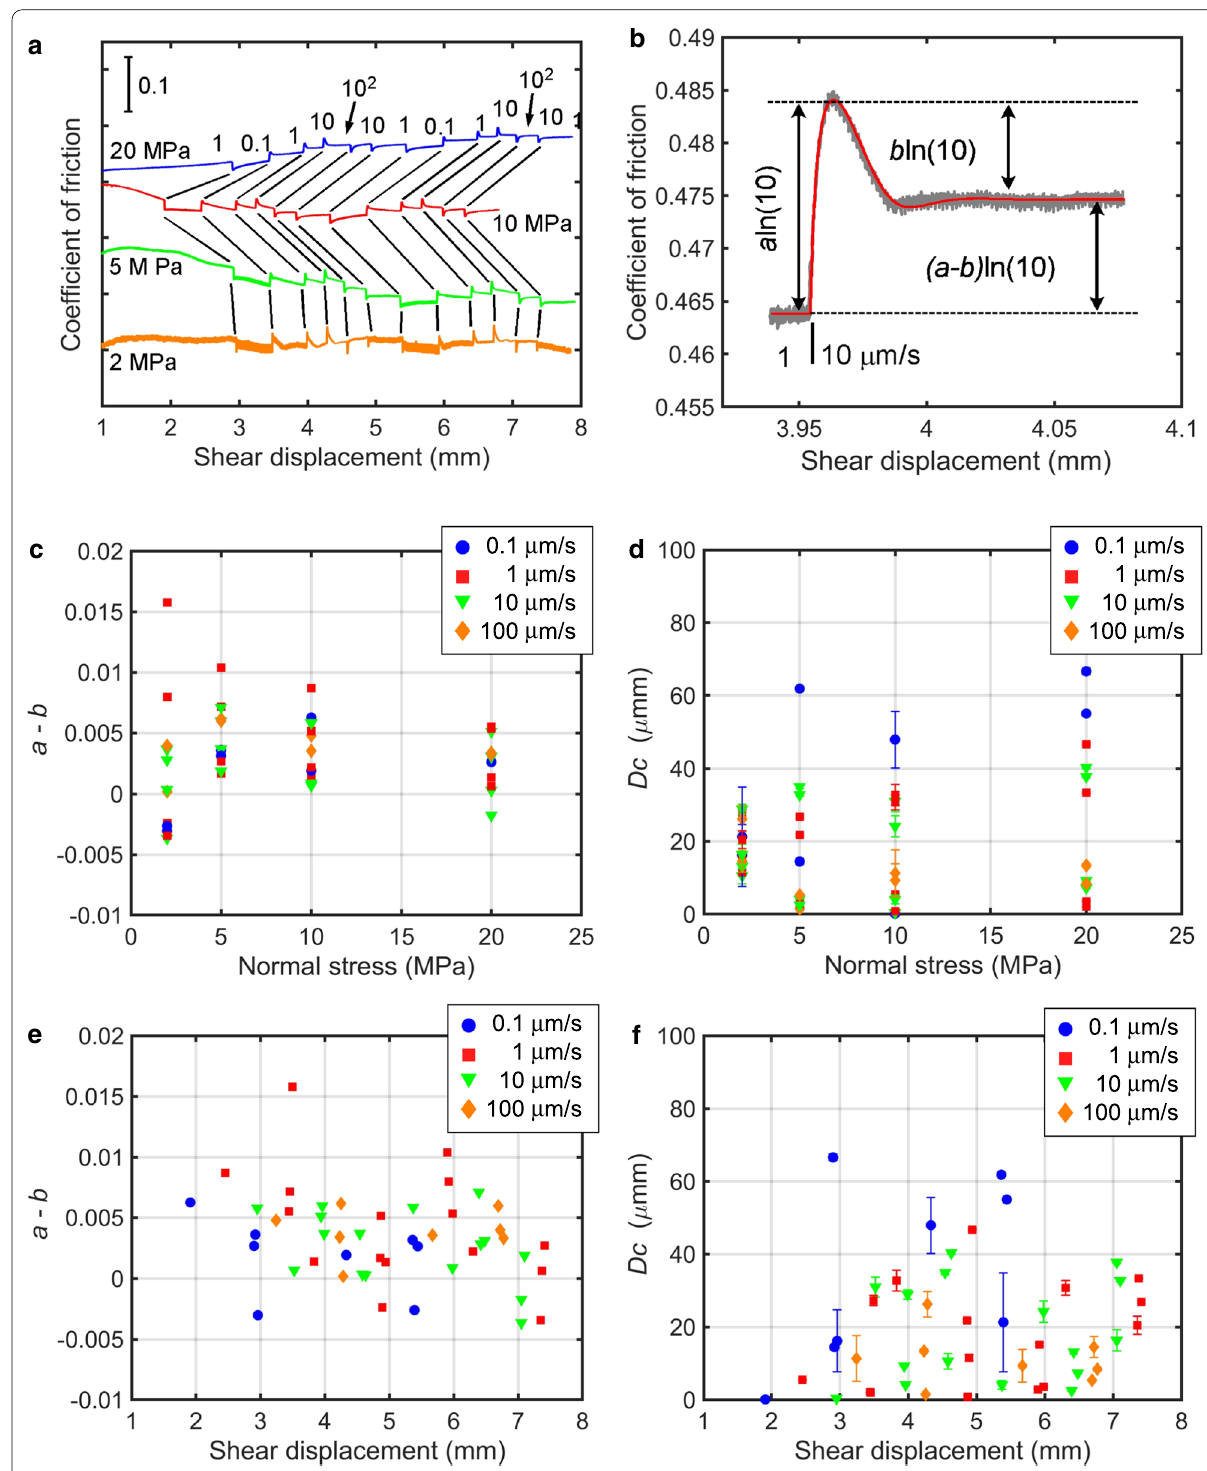
Fig. 5 Experimental data and the friction parameter modeling results. a Friction as a function of shear displacement with velocity steps between 0.1 and 100 μm/s at normal stresses of 2, 5, 10 and 20 MPa. Curves are offset vertically for clarity. b An example of the friction response to a velocity step from 1 to 10 μm/s (gray) with a best‑fitting curve obtained by inversion analysis (red). c Velocity‑dependent friction parameter ( a – b ) and d critical slip distance D c plotted as a function of normal stress for all velocity steps (blue circle, 0.1 μm/s; red square, 1 μm/s; green triangle, 10 μm/s; orange diamond, 100